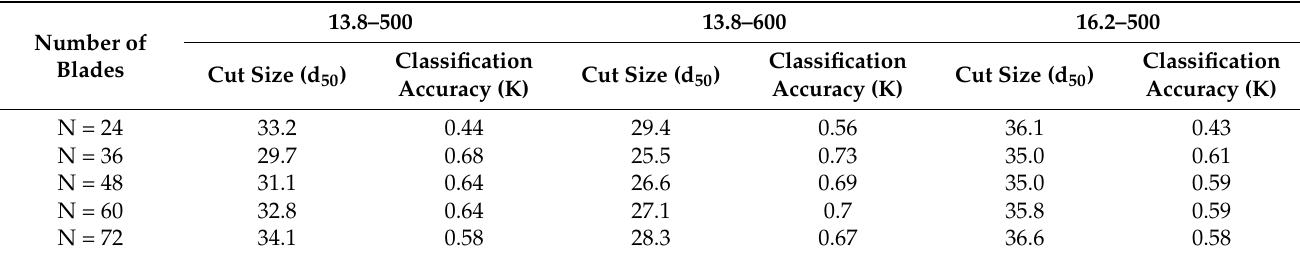
Figure 9. The classification efficiency curves corresponding to the different numbers of blades in different operating conditions. Table 4. The cut size and classification accuracy for the different numbers of blades.